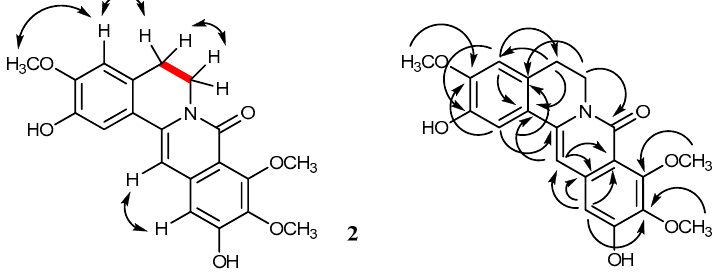
Figure 3. COSY (bold line), NOESY (double arrow line), and HMBC (arrow line) correlations observed for 2 .